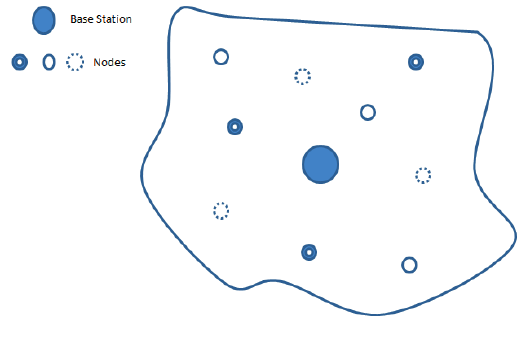
Figure 2. A general overview of node